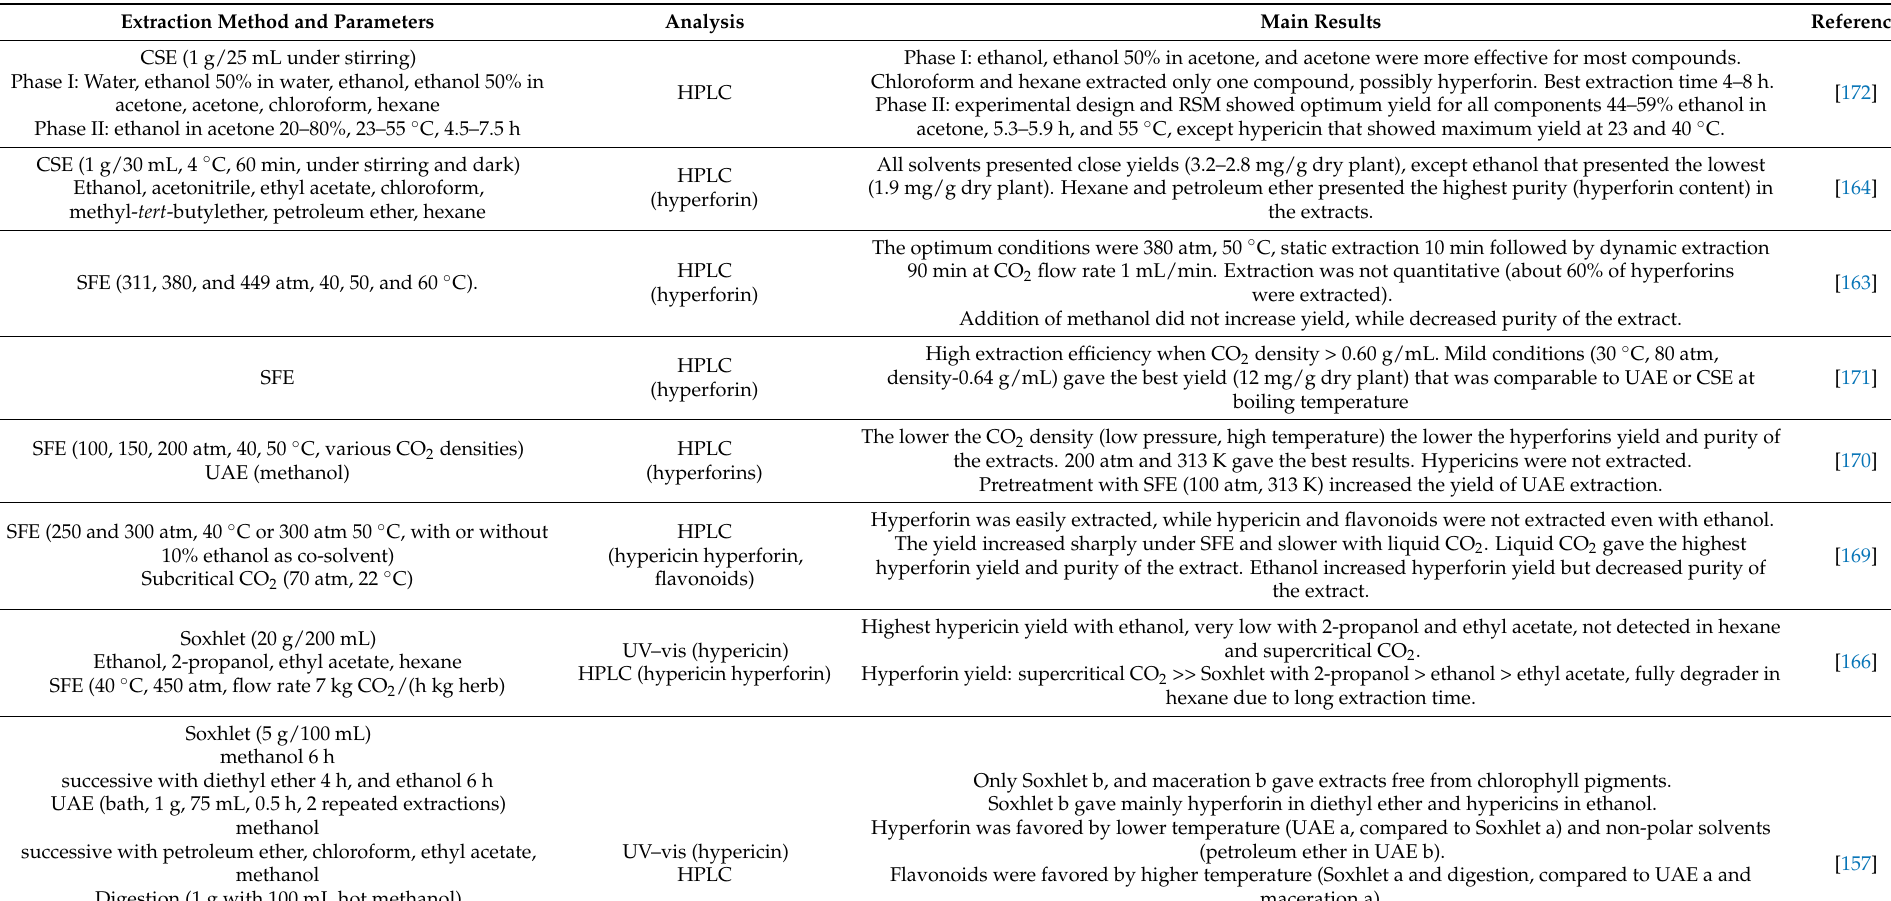
Table 6. Techniques and main results reported in literature for the extraction of phenolic compounds from St. John’s